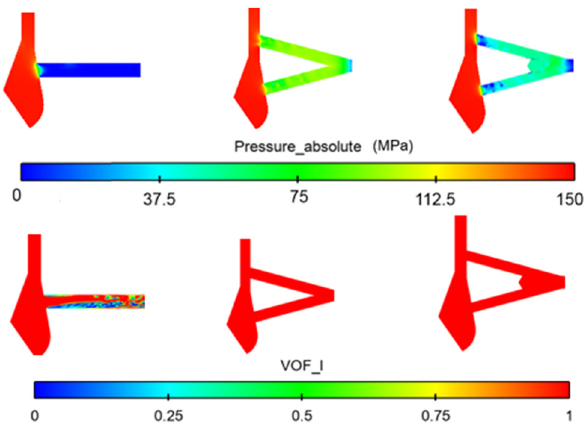
Figure 8: Pressure and liquid volume of the fraction at